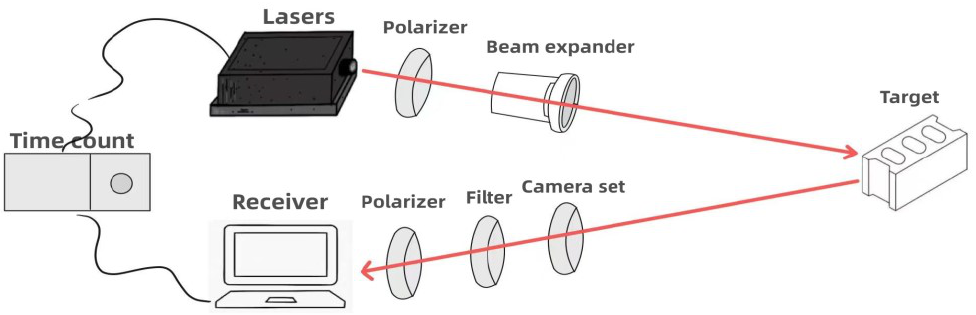
Table 1. A summary of the consistency of the four probe measurements.